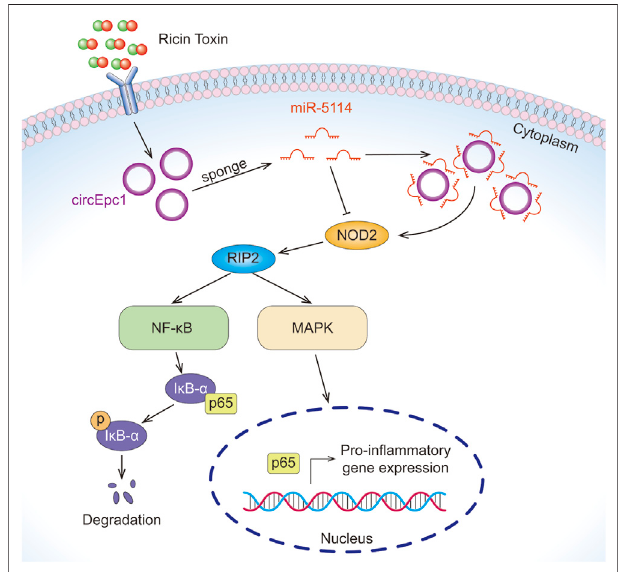
FIGURE 7 | The mechanism of circEpc1 promotes RT-induced in fl ammation through the circEpc1/miR-5114/NOD2 axis.